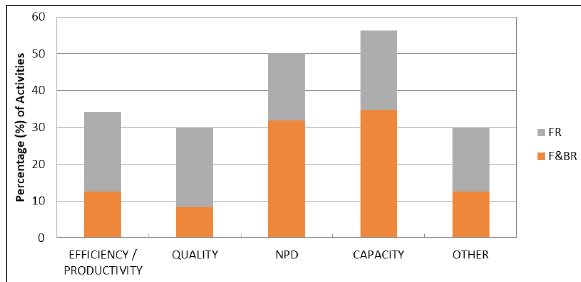
NPD, new product development Figure 4: Rationale for production advances from Food & Beverage Reporter (F&BR) and South African Food Review (FR) data.